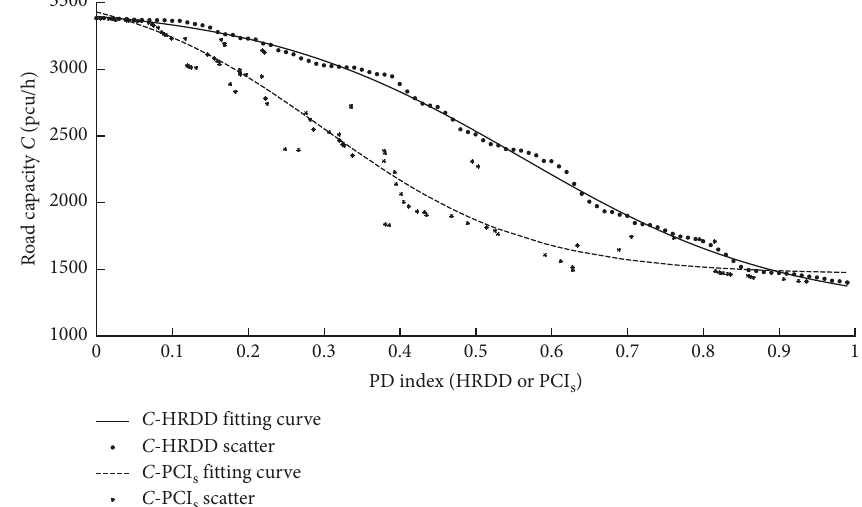
Figure 11: Relationship between road capacity and different types of PD indexes.